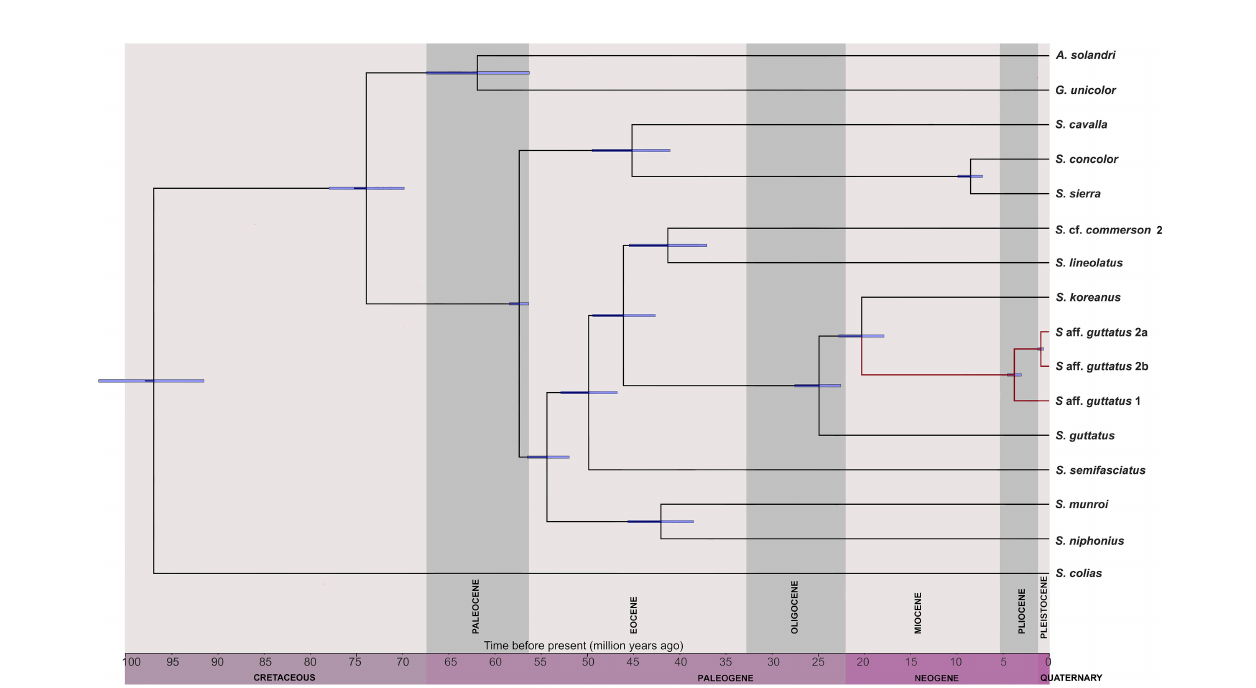
FIGURE 4 | An ultrametric tree of Scomberomorus species (with maximum molecular data) scaled to geographical time is illustrated. Blue bars at the nodes indicate 95% con fi dence interval of internal nodes, and the clade highlighted in red color indicates S. guttatus and its